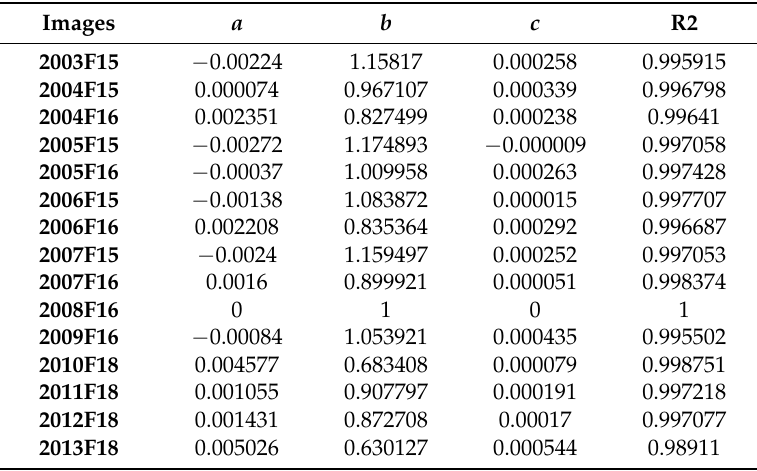
Table 4. Coefficients of the second-order regression models for NTL